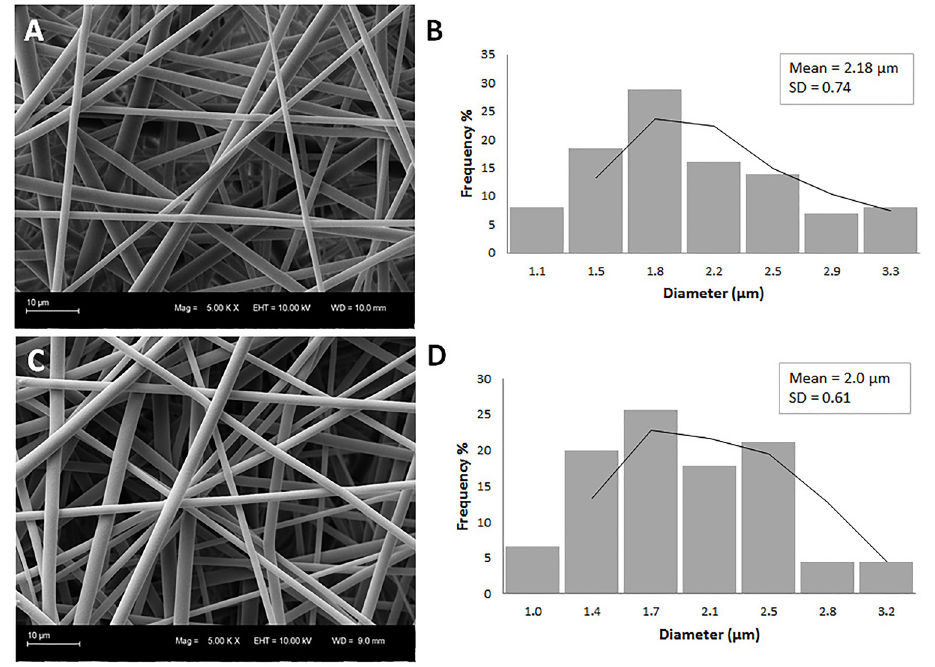
Figure 1. Scanning electron microscopy images showing the morphology of the micro fi bers. A , Poly(lactic-co-glycolic acid) (PLGA) coaxial electrospun fi bers with an average diameter of 2.18 ± 0.74 m m and ( C ) valproic acid (VPA)/PLGA coaxial micro fi bers with an average diameter of 2.0 ± 0.61 m m. B and D show the corresponding histograms of the fi ber diameter distribution. Scale bars: 10 m m.